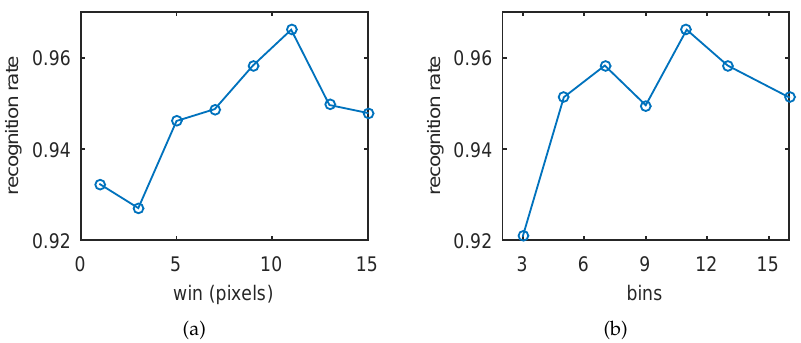
Figure 3. The recognition rate versus the average region size and histogram bins. ( a ) The recognition rate versus the average region size win . win is 1, 3, 5, 7, 9, 11, 13 and 15. ( b ) The recognition rate versus the histogram bins. Bins are 3, 5, 7, 9, 11, 13 and 17.